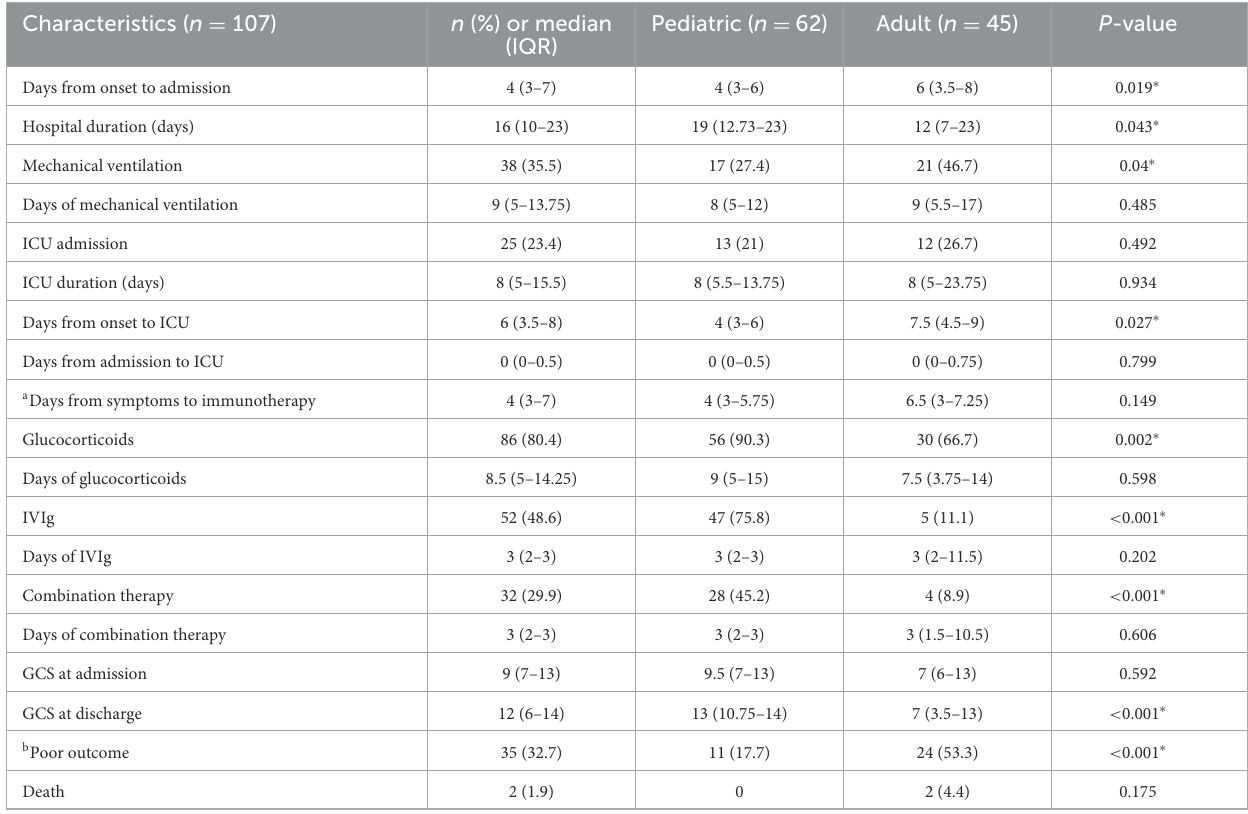
TABLE 5 Clinical course and outcome of pediatric and adult patients with JE. Characteristics ( n =